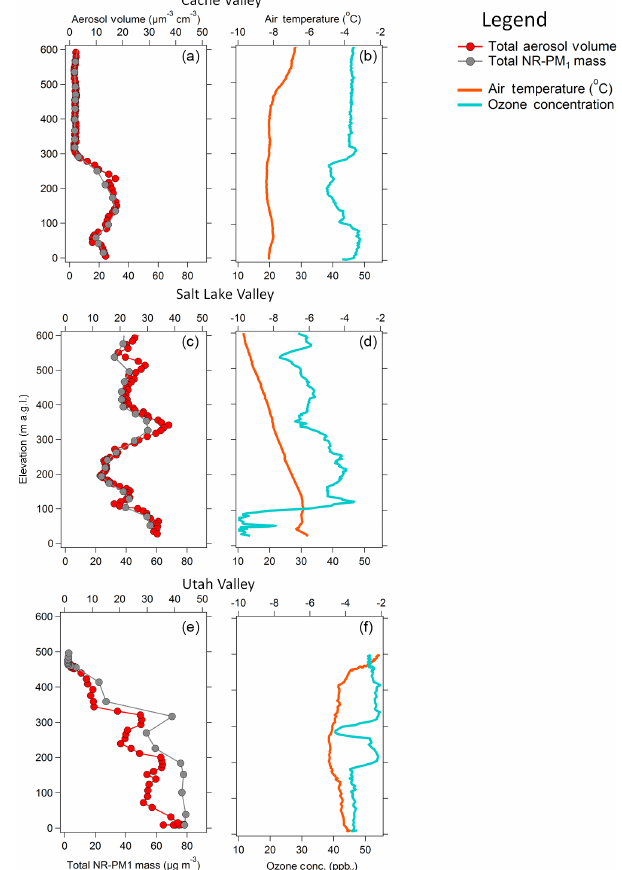
Figure 7. Comparison among selected vertical profiles. On the left the aerosol volume, measured with the UHSAS (in red), and NR- PM 1 mass measured with the AMS (in grey) are shown as a func- tion of elevation in meters above ground level. On the right verti- cal profiles of ozone concentration (light blue) and potential tem- perature (orange) for the same three missed approaches are shown. The missed approach in Cache Valley took place on 28 January at 18:38MST at the Logan-Cache Airport (LGU), the one in Salt Lake Valley on 28 January at 20:22MST at Salt Lake City International (SLC), and the one in Utah Valley on 30 January at 13:24MST at the Provo Municipal Airport